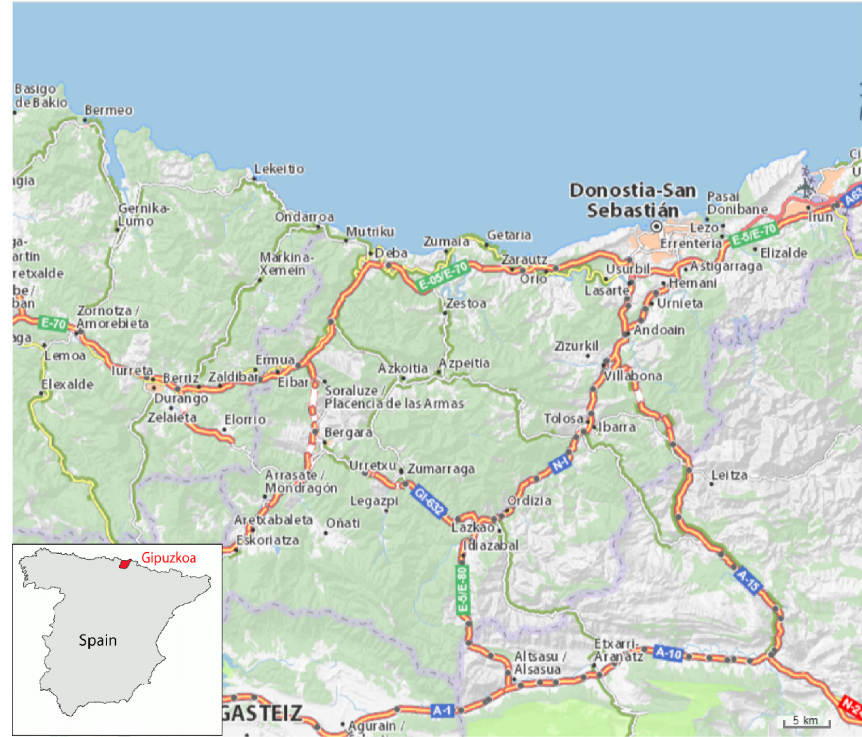
Figure 1. Road network managed by the Gipuzkoa Provincial Council (map source: ViaMichelin website at https://www.viamichelin.com/ web/Maps, last access: September 2018).